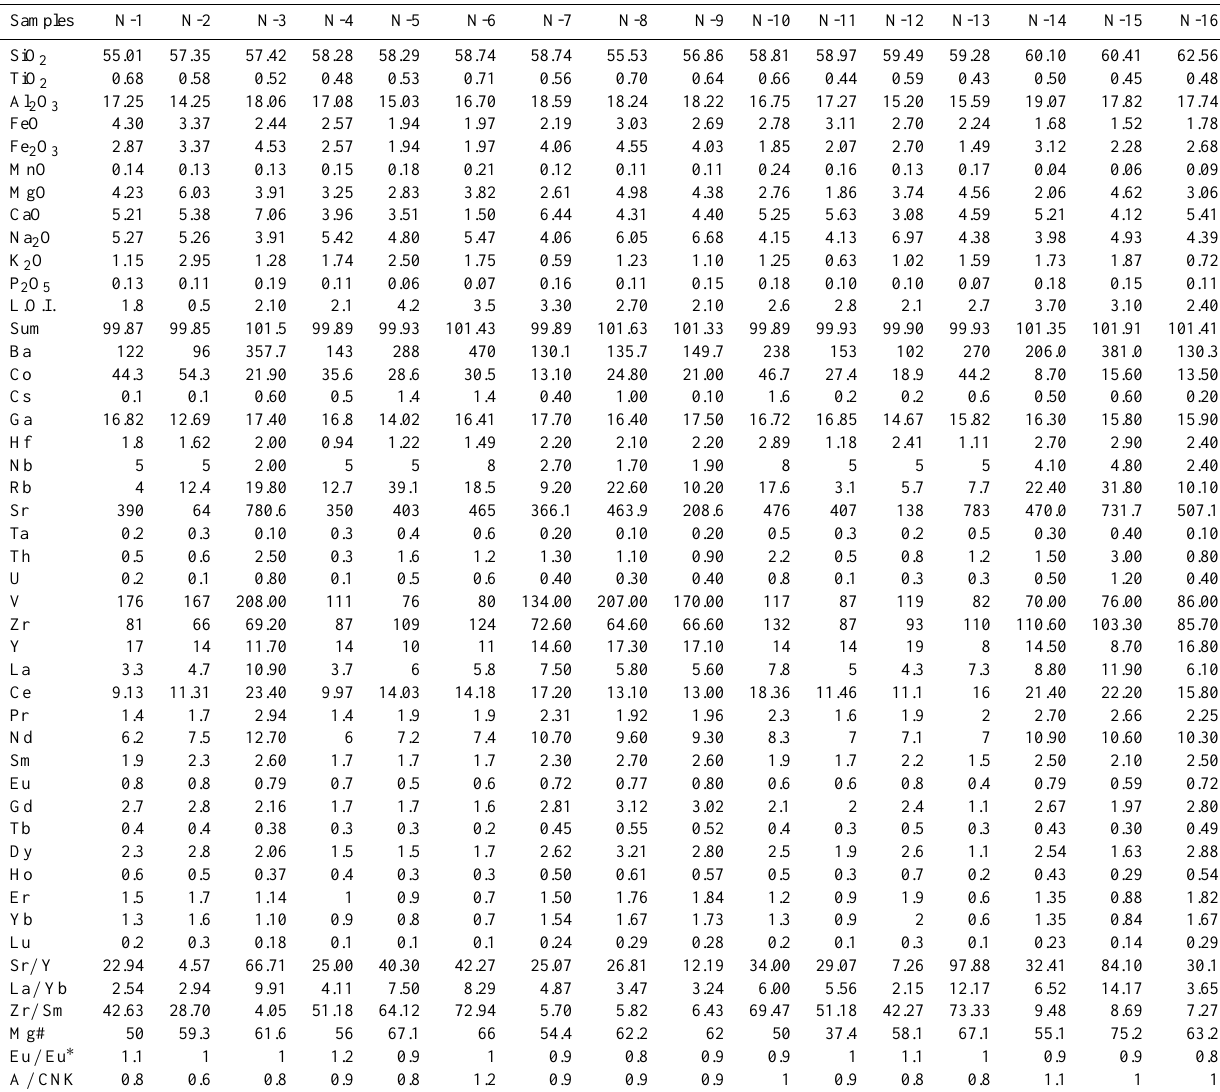
Table 1. Major and trace element contents of representative post-ophiolite subvolcanic samples of in northeast Iran.